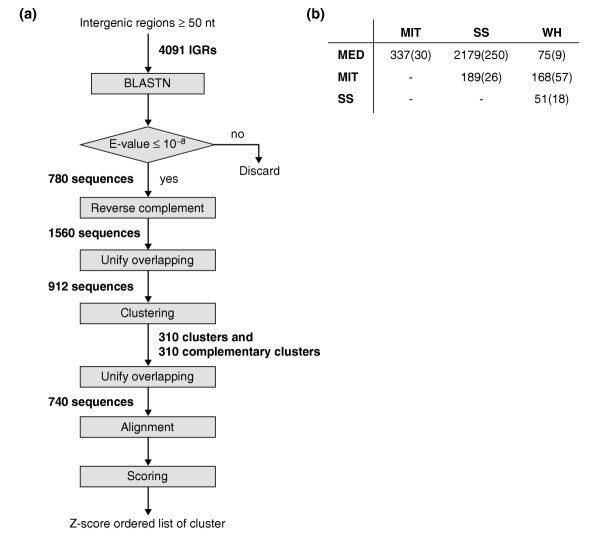
Pipeline for comparative prediction of non-coding RNAs. (a) Intergenic sequences (IGRs) longer than 49 base-pairs were gathered from four Prochlorococcus and Synechococcus genomes and locally aligned using BLASTN. An overview of the intergenic sequences is given in Additional data file 2 (Table S4). Because of the initial asymmetric local alignment using BLASTN (see Figure 2b for a summary of significant BLASTN hits between the strains Prochlorococcus MED4 (MED), MIT 9313 (MIT), SS120 (SS) and Synechococcus WH 8102 (WH)), all candidate sequences were reverse-complemented. Redundancy in this data set was reduced by unifying those hits from each genome that showed a reciprocal overlap of 85% or greater. This candidate set was used as both query and subject in another local alignment step (BLASTN considering only the query strand as possible subject strand). Sequences that directly produced a significant blast hit (E-value ≤ 10-10), or were connected by a chain of such hits, were gathered into clusters ('single-linkage clustering'). Both genome strands were screened; thus, the pipeline produced 310 pairs of clusters in both forward and reverse complementary orientation. After an additional unification step of overlapping sequences within each cluster, the resulting clusters and their complement clusters were scored using ALIFOLDZ [33]. (b) The number of BLASTN high-scoring segment pairs for each query and subject combination of intergenic regions is given for a BLASTN E-value cut-off of 10-5 and after import of high-scoring segment pairs with an E-value of 10-10 or lower (in parentheses). MIT, Prochlorococcus strain MIT 9313; SS, Prochlorococcus strain SS120; WH, Synechococcus sp. WH 8102, MED, Prochlorococcus strain MED4.